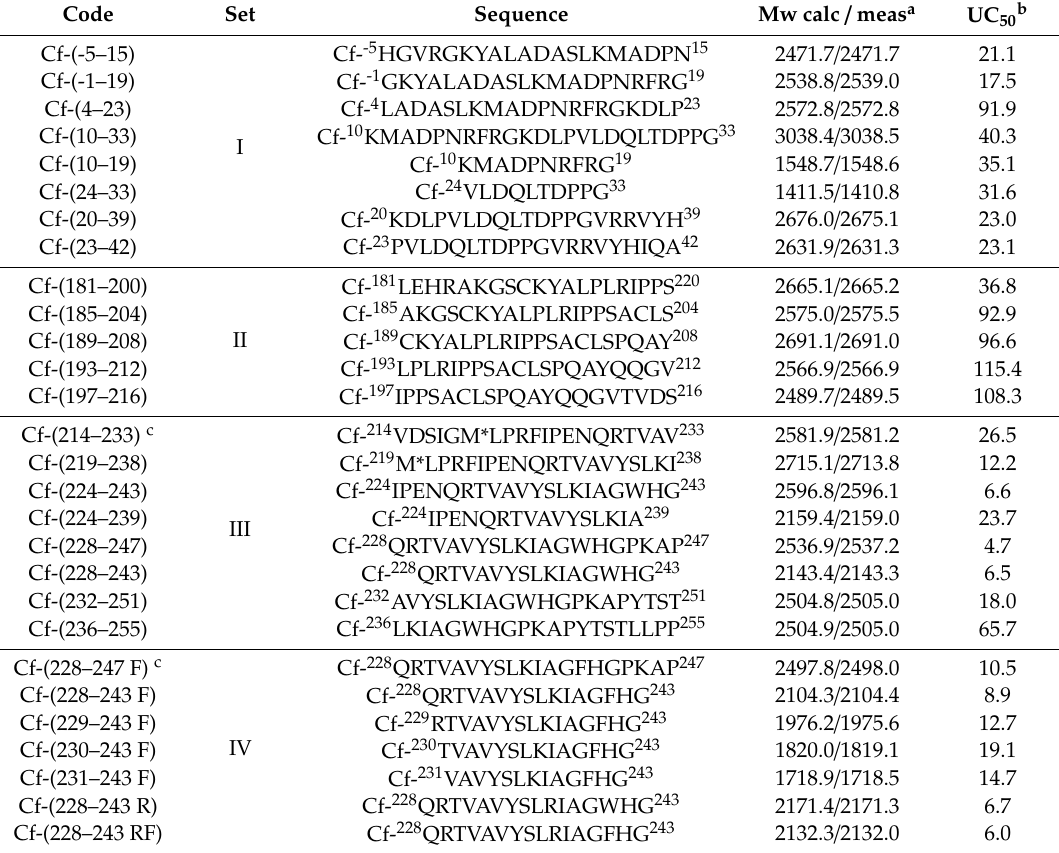
Table 1. Analytical evaluation of Cf-labelled HSV-1 gD synthetic